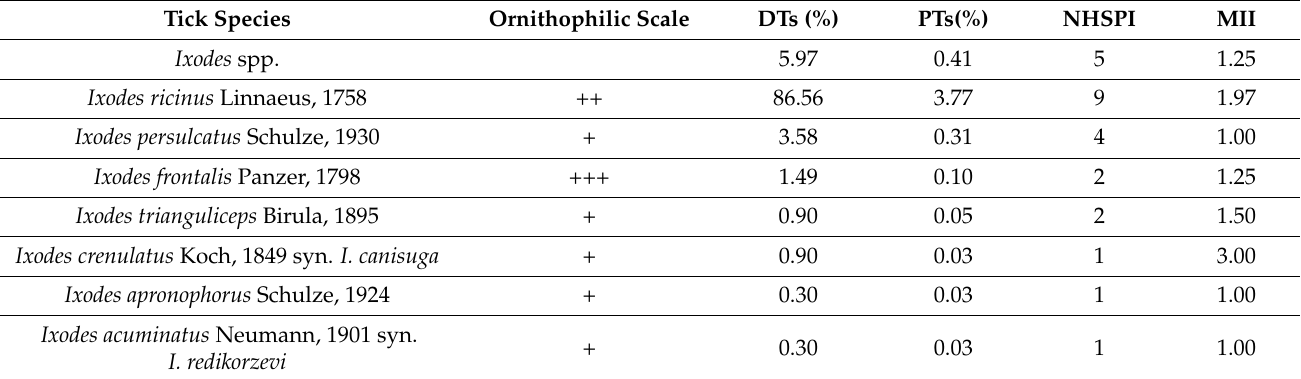
Figure 3. Quantitative and qualitative structure of collected ticks. Nymphs are only the developmental stages of ticks collected from birds. I. ricinus is the most frequent tick species infesting birds. Table 3. Quantitative characteristics of ticks collected from captured Table 2. Ticks infesting birds and bird behavior type.